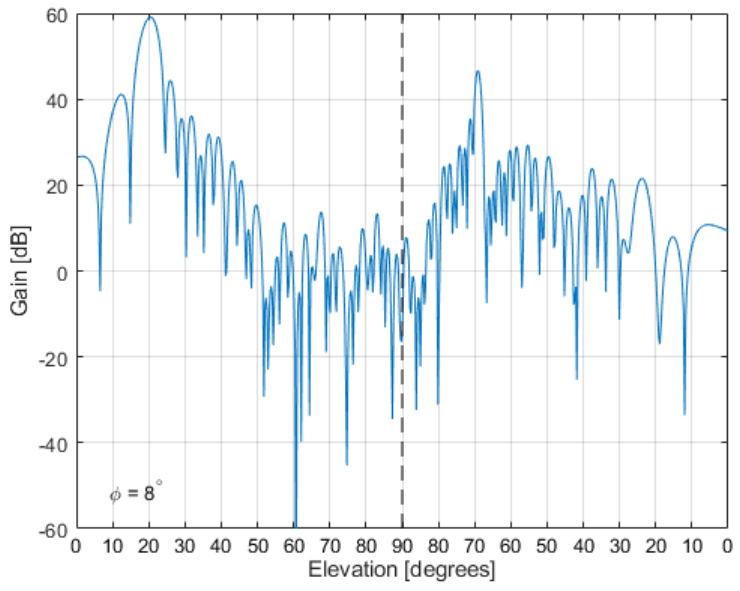
Figure 14. Vertical cut at 8 ◦ azimuth of the beam pattern of the LOFAR station with the beam steered at φ st = 8 ◦ and θ st = 20 ◦ .